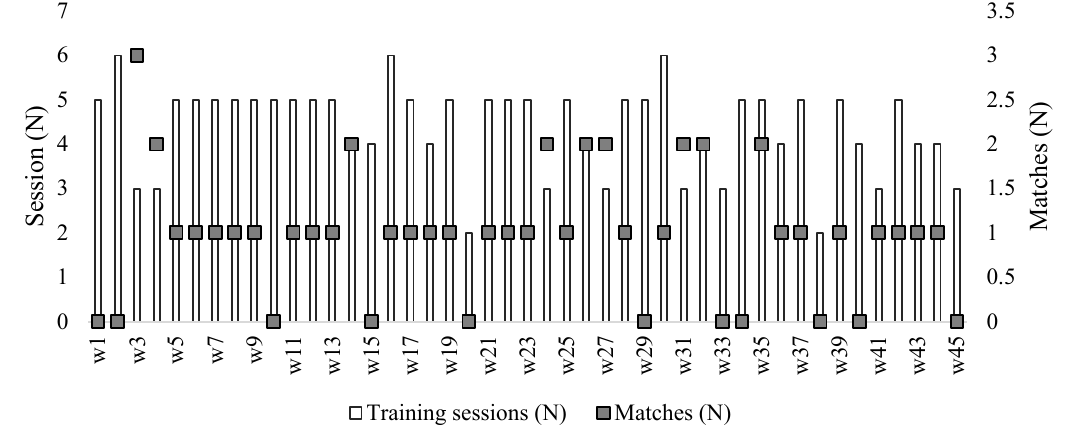
Figure 1. Timeline of the observational study and number of sessions and matches. w: number of the week in the timeline.